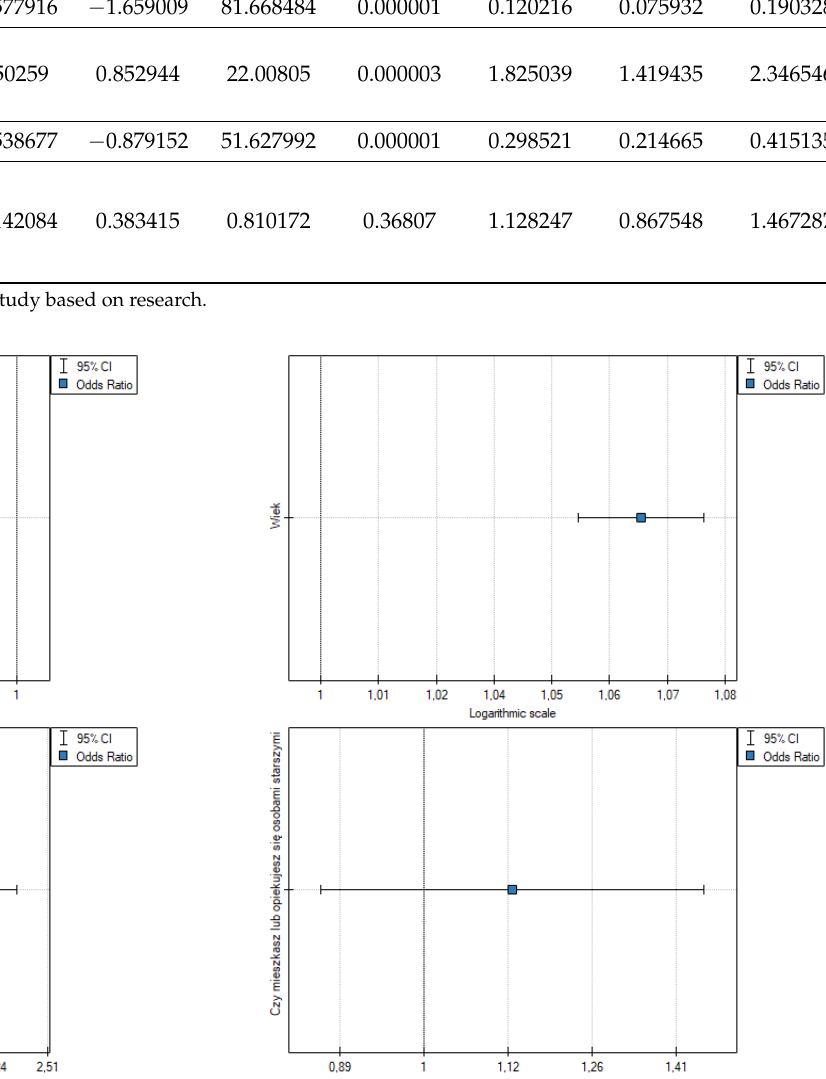
Table 6. Logistic regression model for somatic fear symptoms and demographics.